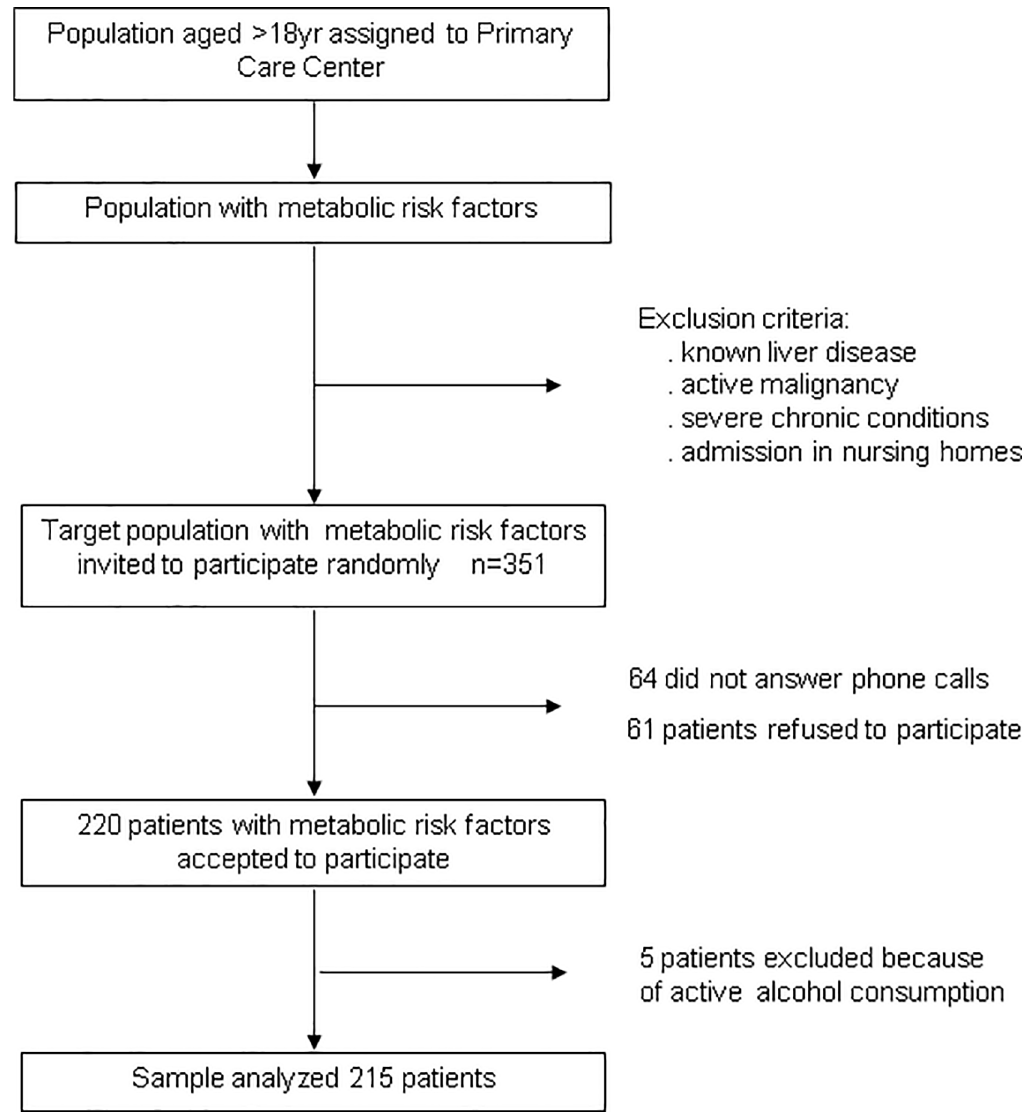
Fig 1. The flow chart of the